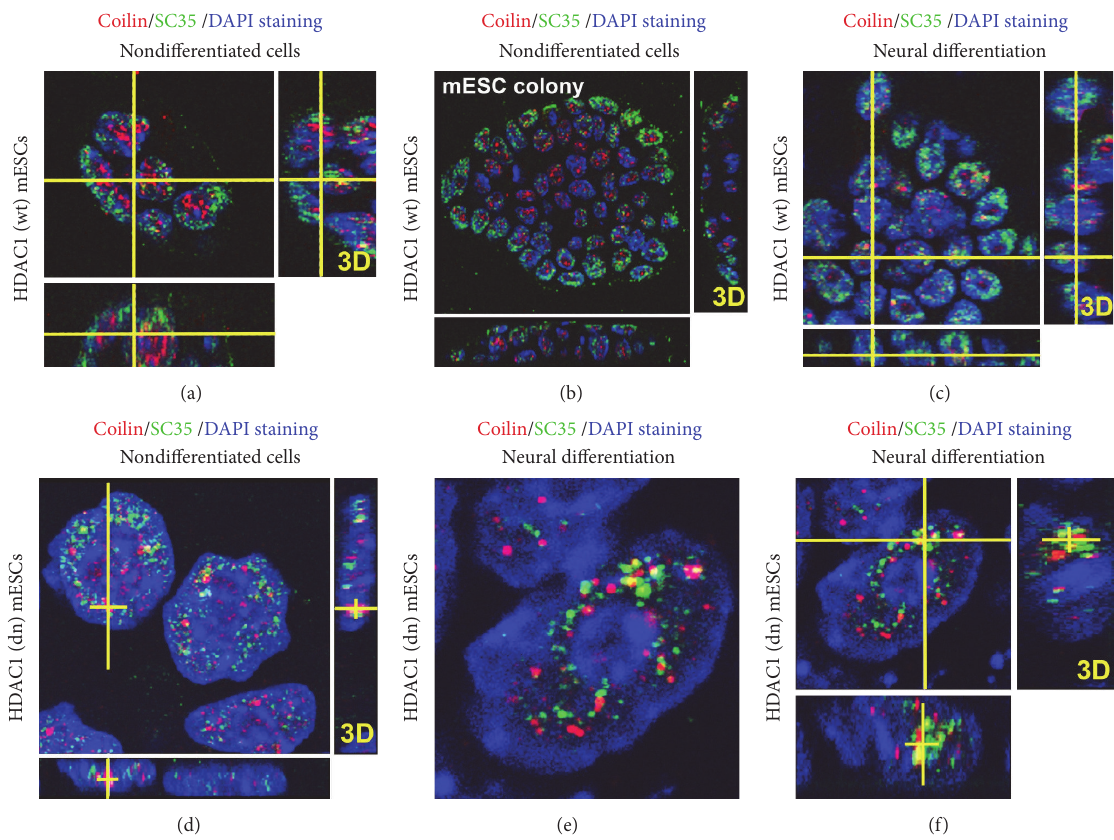
Figure 6: Spatial interactions between coilin and SC35-positive splicing speckles. (a) In wt mESCs, coilin (red) was distributed in the nuclear interior, and this coilin-positive region was surrounded by SC35 protein (green). (b, c) show that the mutual interaction between coilin and SC35 is changed during neural differentiation. Many cells were characterized by the formation of SC35-positive CBs (red). The colocalization tool in the Leica software showed ∼ 30% colocalization between CBs (red) and SC35-positive nuclear speckles (green) in both (d) nondifferentiated HDAC1 dn mESCs and (e, f) differentiated HDAC1-depleted cells. A 3D projection (𝑥 - 𝑦 - 𝑧) of interphase nuclei is documented in all